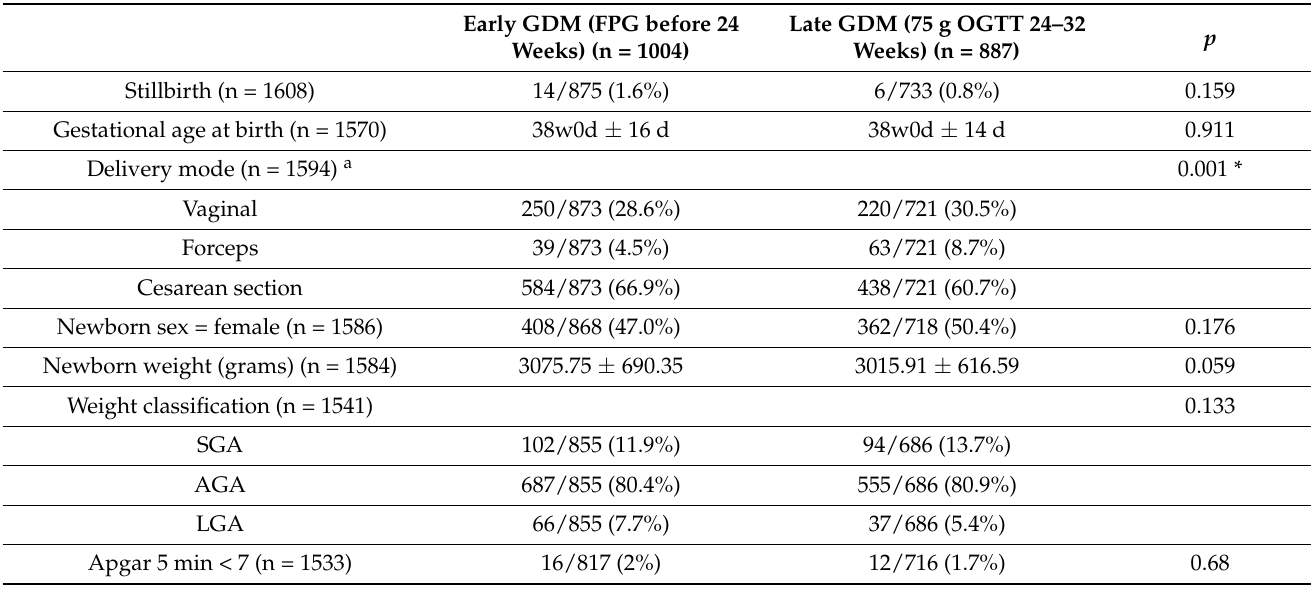
Table 2. Birth and newborn characteristics for women diagnosed with early or late gestational diabetes.